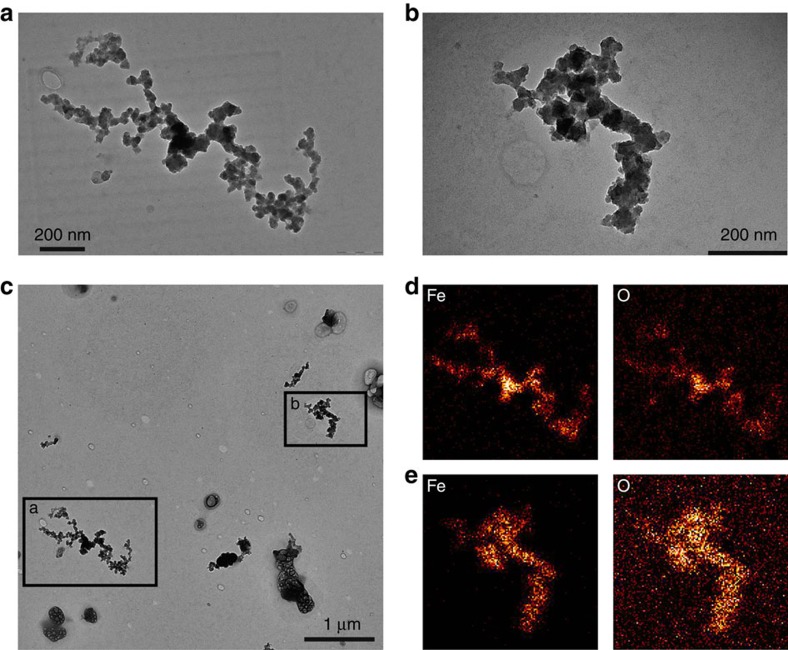
Transmission electron microscopy images and element distributions of aggregated iron oxide nanoparticles found in dry PBL air.The sample was collected using an aerosol-impactor sampler onboard the aircraft from 14:35 to 14:47 on 4 March 2013 (local time) during the A-FORCE 2013W campaign (that is, Sample number 1 in Table 1). The particles magnified in a and b were collected on the same substrate with an inter-particle distance of ∼4 μm, as shown in c. The elemental distributions of Fe and O for particles a and b are shown in d and e, respectively, and indicate that these particles contain iron oxide.